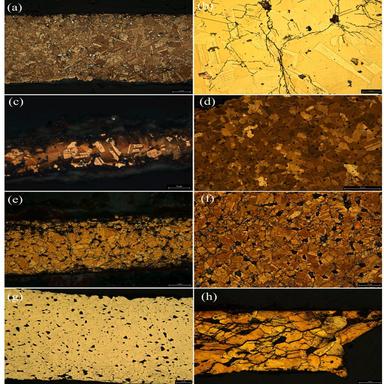
Photomicrographs of some of the samples studied, showing all having a recrystallized equiaxed grain structure. a) DHK1with annealing twins, remaining (α+δ) eutectoids and slight elongation of the sulfide inclusions; b) DH8 with annealing twins, residual strain lines and corrosion along grain boundaries; c) ZSL11 with annealing twins, slight elongation of the sulfide inclusions and deep corrosion; d) WFT19 with annealing twins and casting pores; e) XJN22 with slightly distorted annealing twins and strain lin